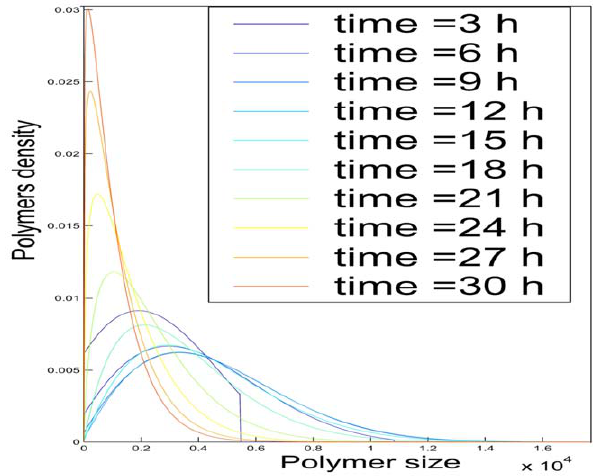
Figure 4. Adimensionned Distributions of the sizes of polymers for various times. To obtain adimensionned distributions of polymer sizes, our model was applied to data taken from Figure 1 of [7]. From 6 to 18 hours one can see that the distribution remains roughly stable.